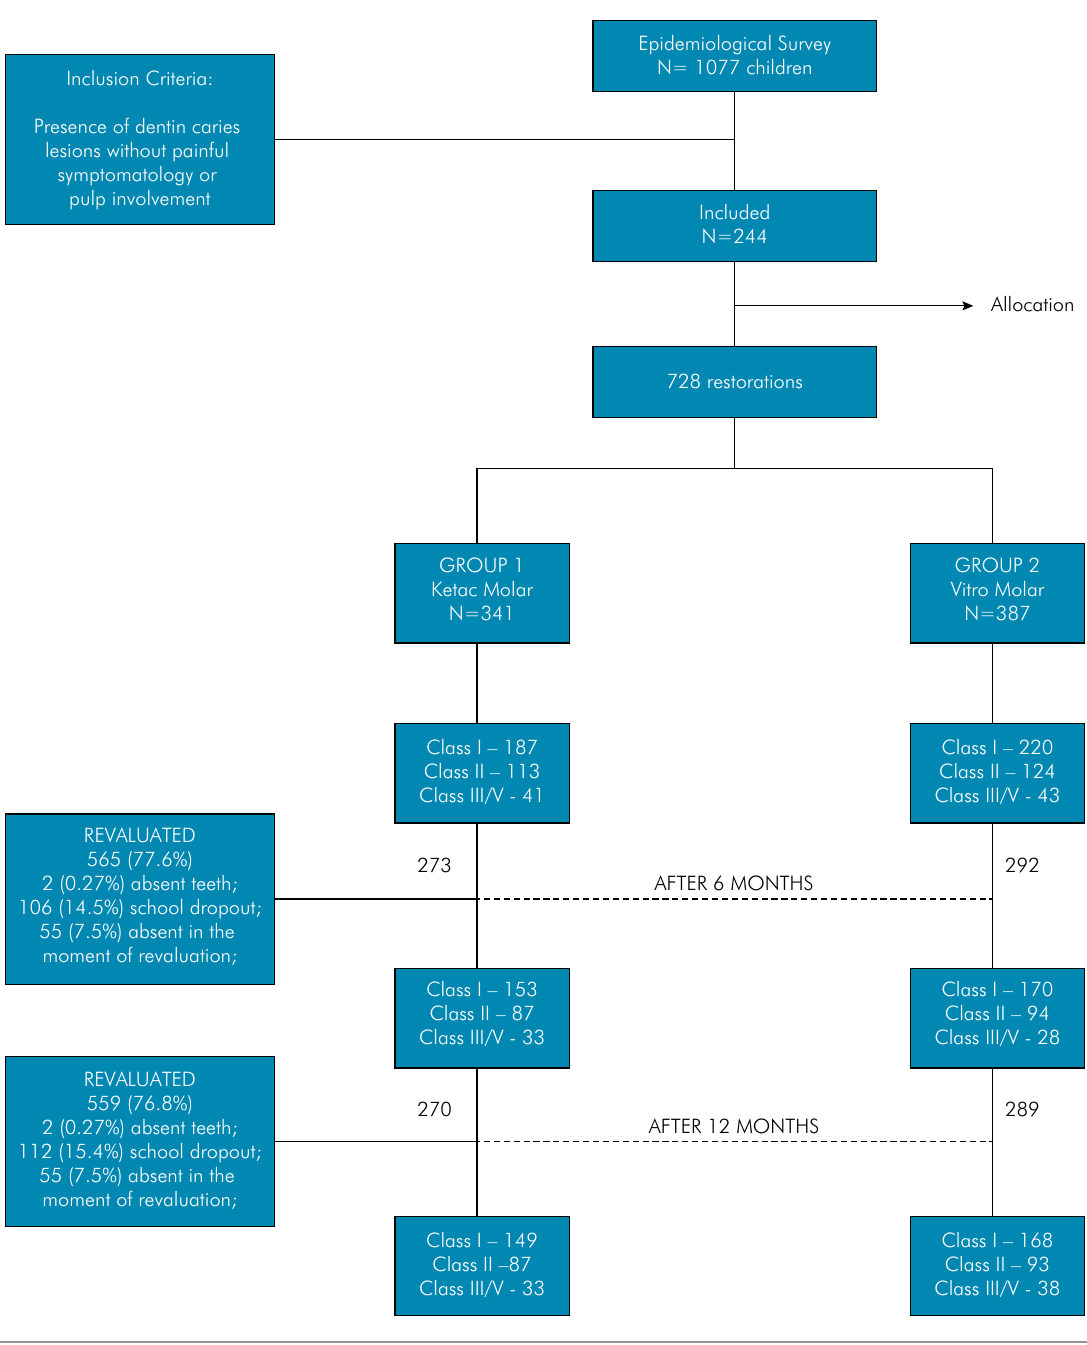
Figure. Flowchart of the